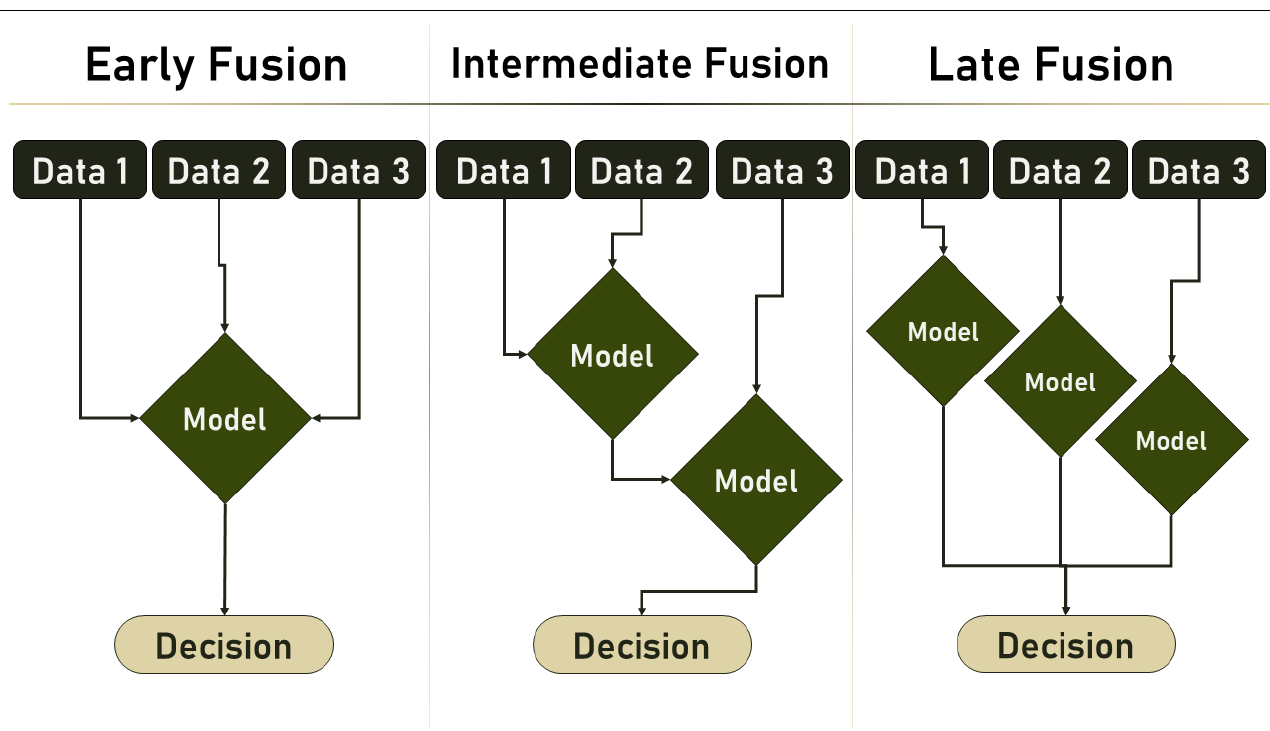
Figure 3. Data fusion